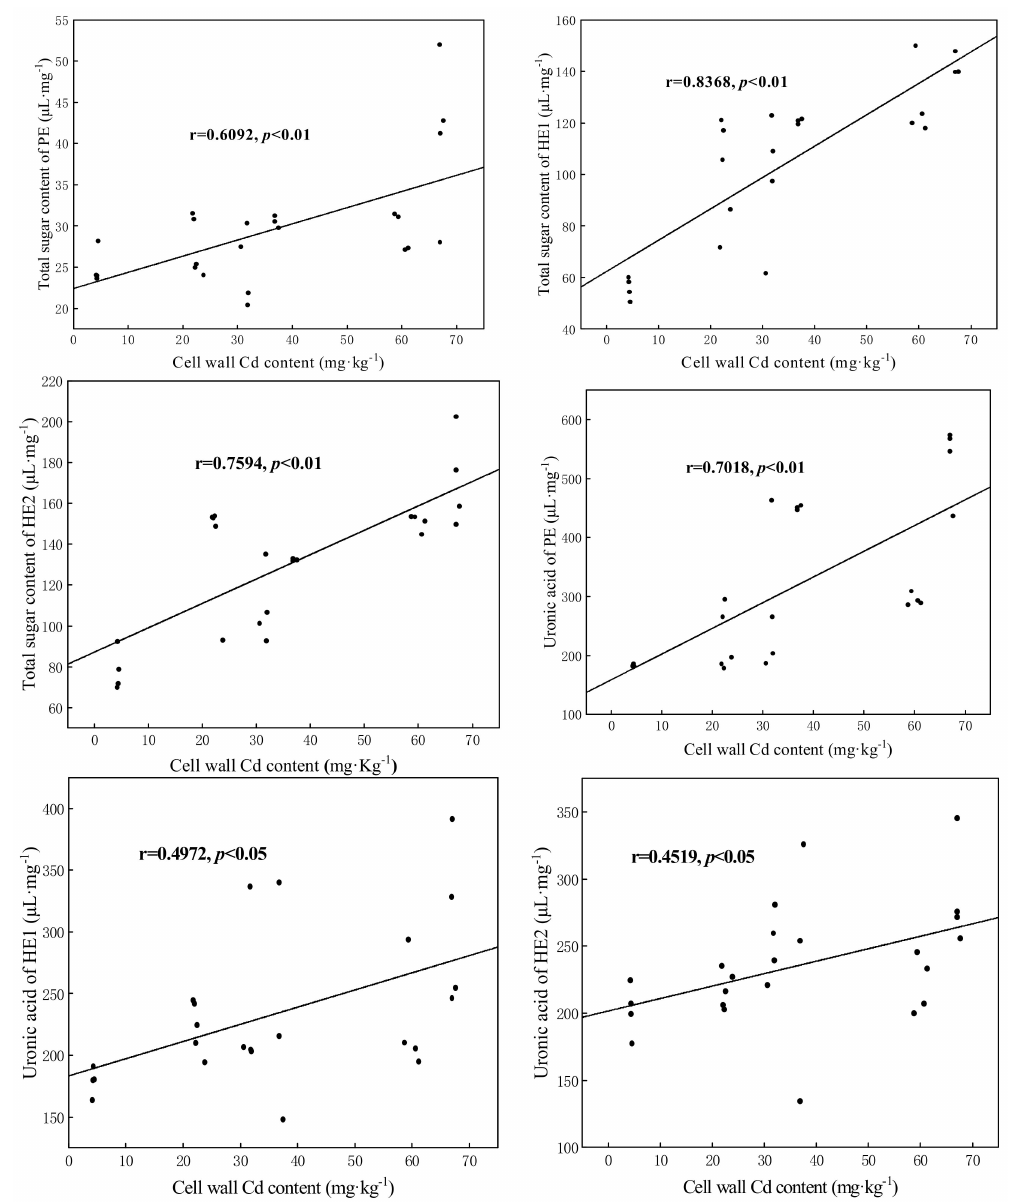
Figure 6. Correlation analysis between maize RCW Cd content and cell wall components. PE: pectin; HE1: hemicellulose–1; HE2: